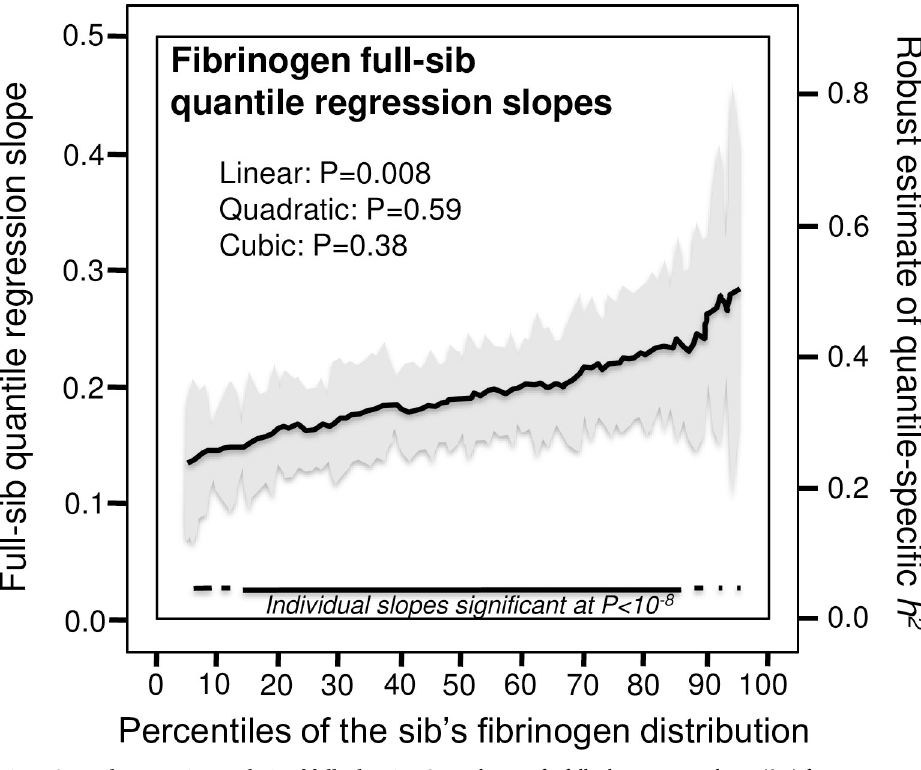
Fig 2. Quantile regression analysis of full-sib pairs. Quantile-specific full-sib regression slopes ( β FS ) from 5379 siblings in 1932 sibships, with corresponding estimates of heritability as estimated by h 2 = {(8r spouse β FS +1) 0.5 –1}/ (2r spouse )